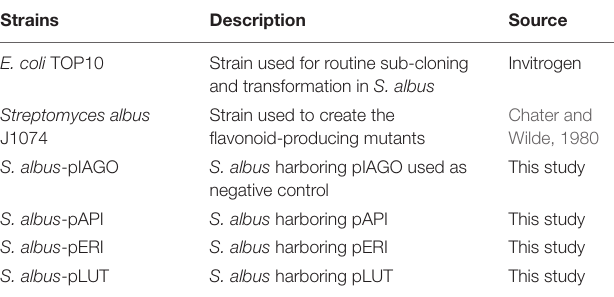
TABLE 2 | List of strains used in this